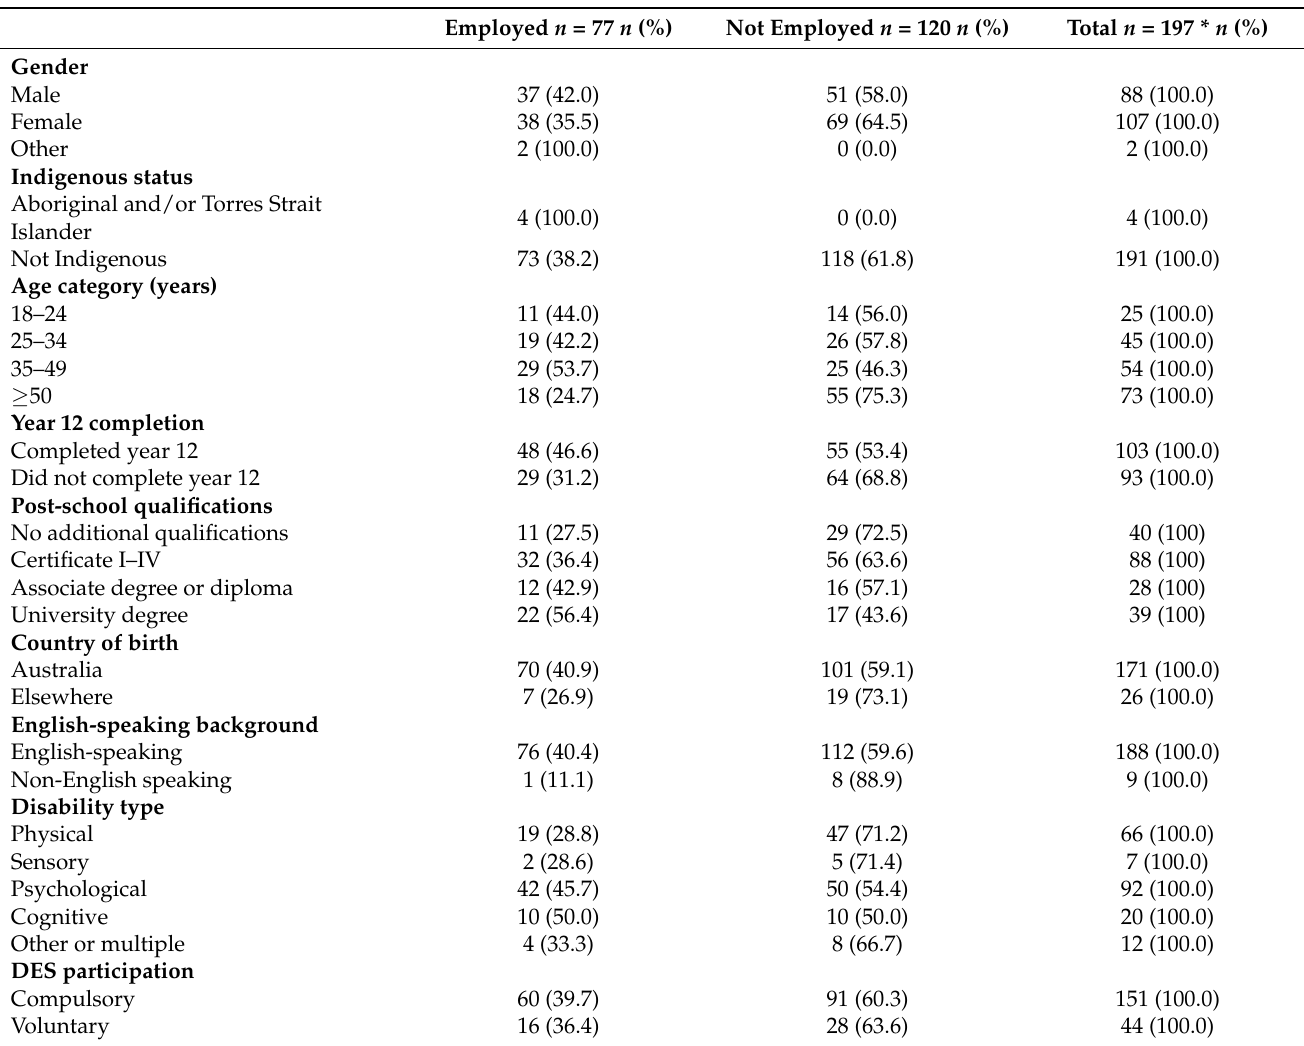
Table 1. Wave 1 characteristics of IDES participants by Wave 2 employment status ( n =